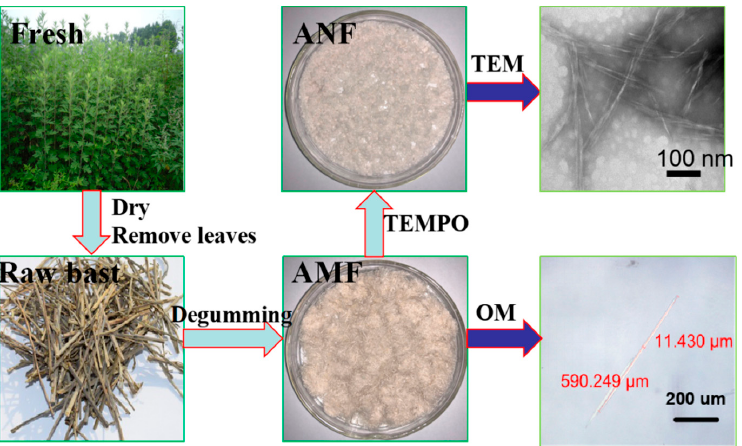
Figure 1. Flowchart of the Artemisia vulgaris bast microcellulose fiber (AMF) and Artemisia vulgaris bast nanocellulose fiber (ANF) extraction. (TEM, transmission electron microscopy. OM, optical microscopy. TEMPO, 2,2, 6,6 ‐ tetramethylpiperidine ‐ 1 ‐ oxyl).